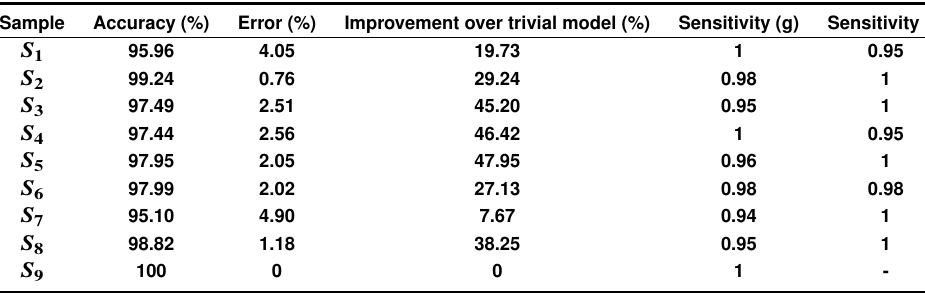
Table 6. Confusion matrix over S i after using the decision tree